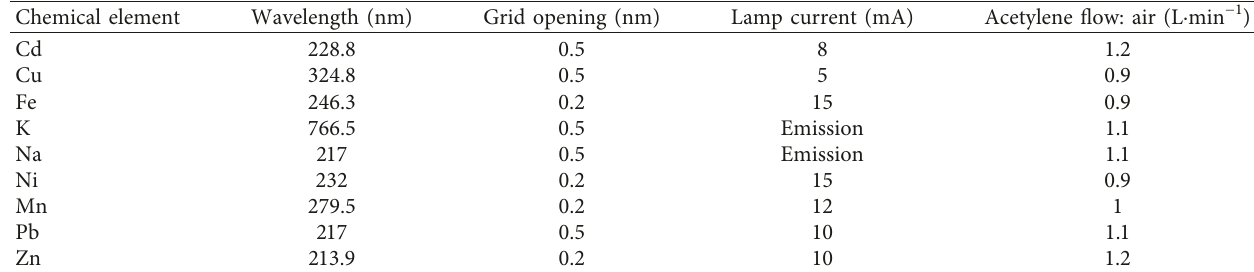
Table 1: Atomic absorption equipment operating conditions for determination of the metals concentration in oil and Amazon sailfin catfish biodiesel.